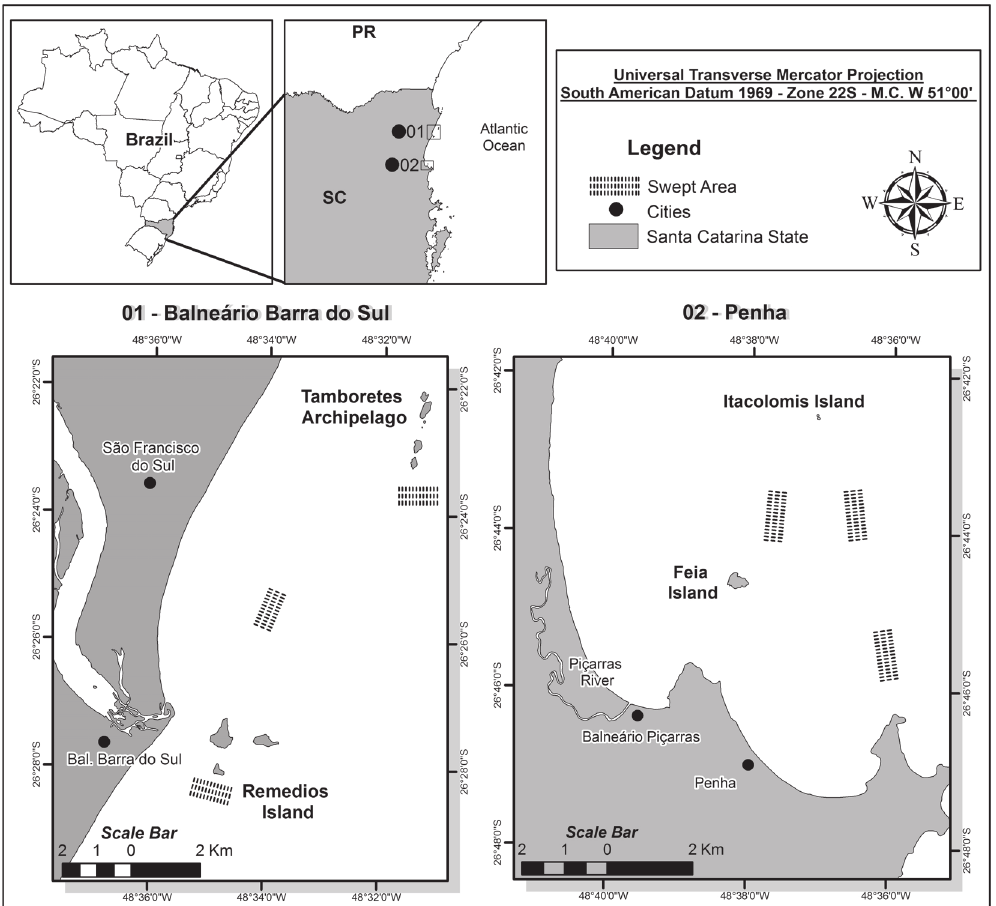
Figure 1. Site map of Balneário Barra do Sul and Penha showing traditional seabob shrimp fishing areas where the trawlings were